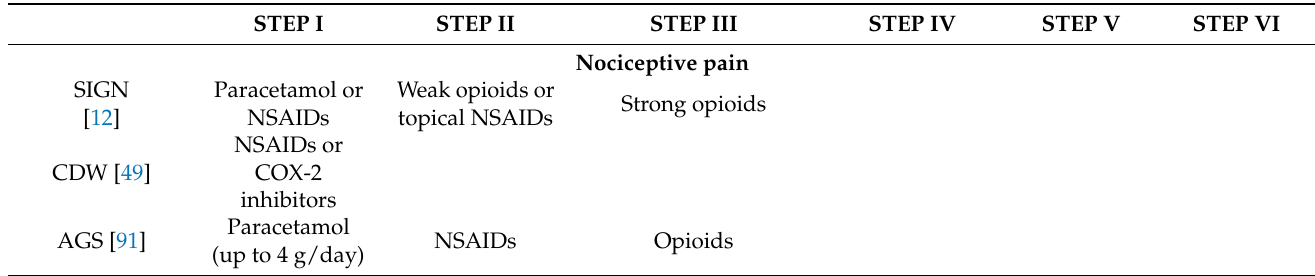
Table 3. International guidelines for chronic pain. SIGN: Scottish Intercollegiate Guidelines Network; CDW: Colorado Division of Workers; AGS: American Geriatric Society; COX: cyclooxygenase; DHHS: Department of Health and Human Services; NeuPSIG: Neuropathic Pain Special Interest Group;